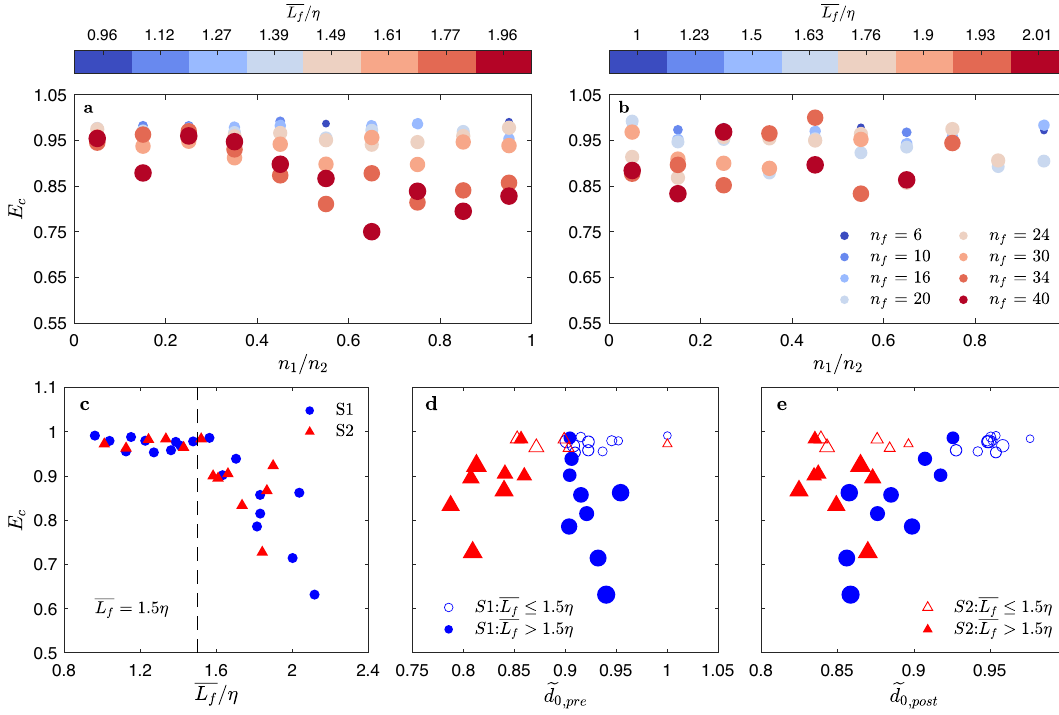
Figure 4. The effects of floc properties and turbulent modulation on the aggregation efficiency. ( a, b ) Dependence of aggregation efficiency ( E c ) on the pre-collision floc size ratio ( n 1 / n 2 < 1 ) for all aggregation resulting in given n f . The resultant floc size over the Kolmogorov length scale ( L f /η ) is indicated by the color 24 or L 1.5 η in case S1 (see a ) and all flocs in case S2 (see b ), E bar. For flocs of n f c is independent of to f < ≤ the floc size ratio before aggregation. For large flocs of L f > 1.5 η in case S1 (see a ), E c is high when two flocs 0 ) collide, while E 1 ). of very different size ( n 1 / n 2 c is low for the collision of two equal-sized flocs ( n 1 / n 2 ∼ ∼ ( c ) Relation between the aggregation efficiency E c and the resultant normalized floc size ( L f /η ) of equal-sized 1.5 η . ( d, e ) Relation between 1 . E collision with n 1 / n 2 c decreases when the post-collision floc size L f > ∼ aggregation efficiency E c and the pre- and post-collision floc structures (characterized by the normalized fractal d 0 ), when two flocs with equal n f collide. For aggregation generates flocs smaller than 1.5 η (hollow dimension markers), E c is high for both cases and is independent of both the pre- and post-collision floc structures. For aggregation that results in flocs larger than 1.5 η (see d , filled markers), E c decreases as pre-collision flocs become (cid:31) larger and compact in case S1, while as pre-collision flocs becomes larger and irregular in case S2. When two equal-sized flocs of increasingly compact structure aggregate in S1 (see d , filled blue circle), the resultant larger flocs become increasingly irregular with decreasing fractal dimension(see e , filled blue circle). When two equal- sized flocs of more irregular structure aggregate in case S2 (see d , filled red triangle), the resultant larger floc is more compact with increasing fractal dimension (see e , filled red